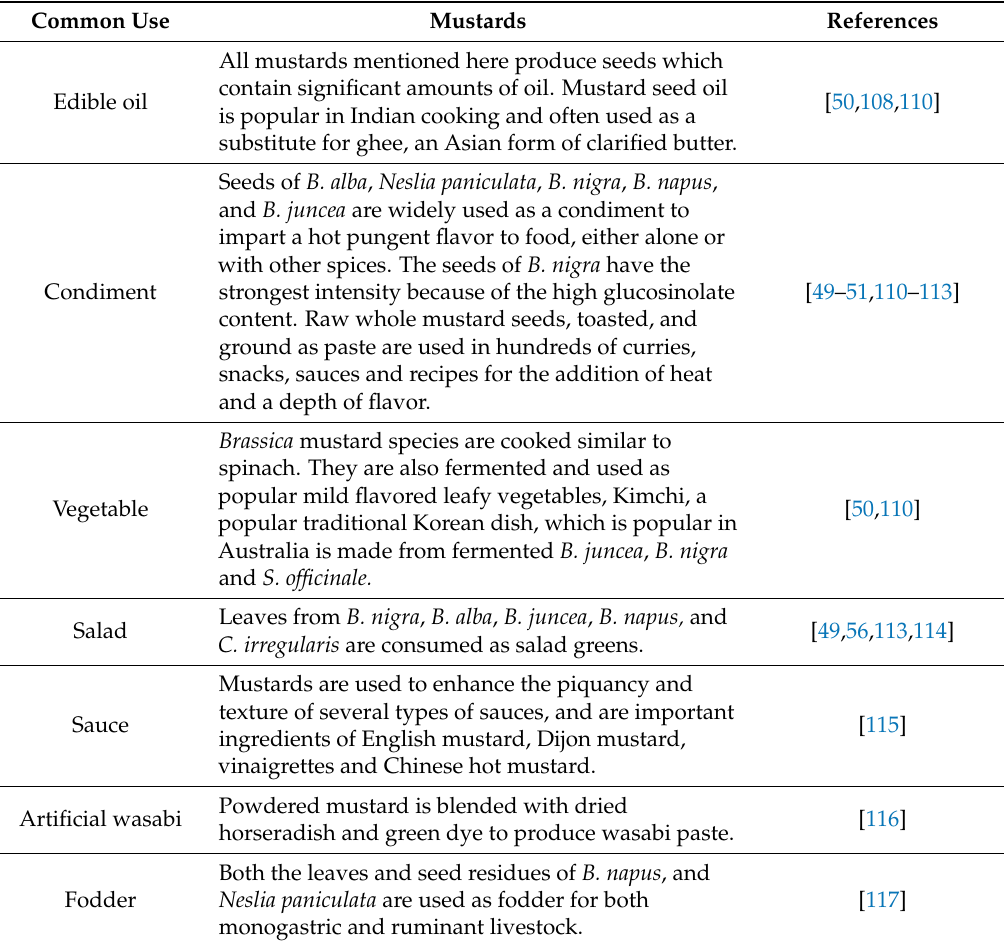
Table 2. Uses of mustard as a main food